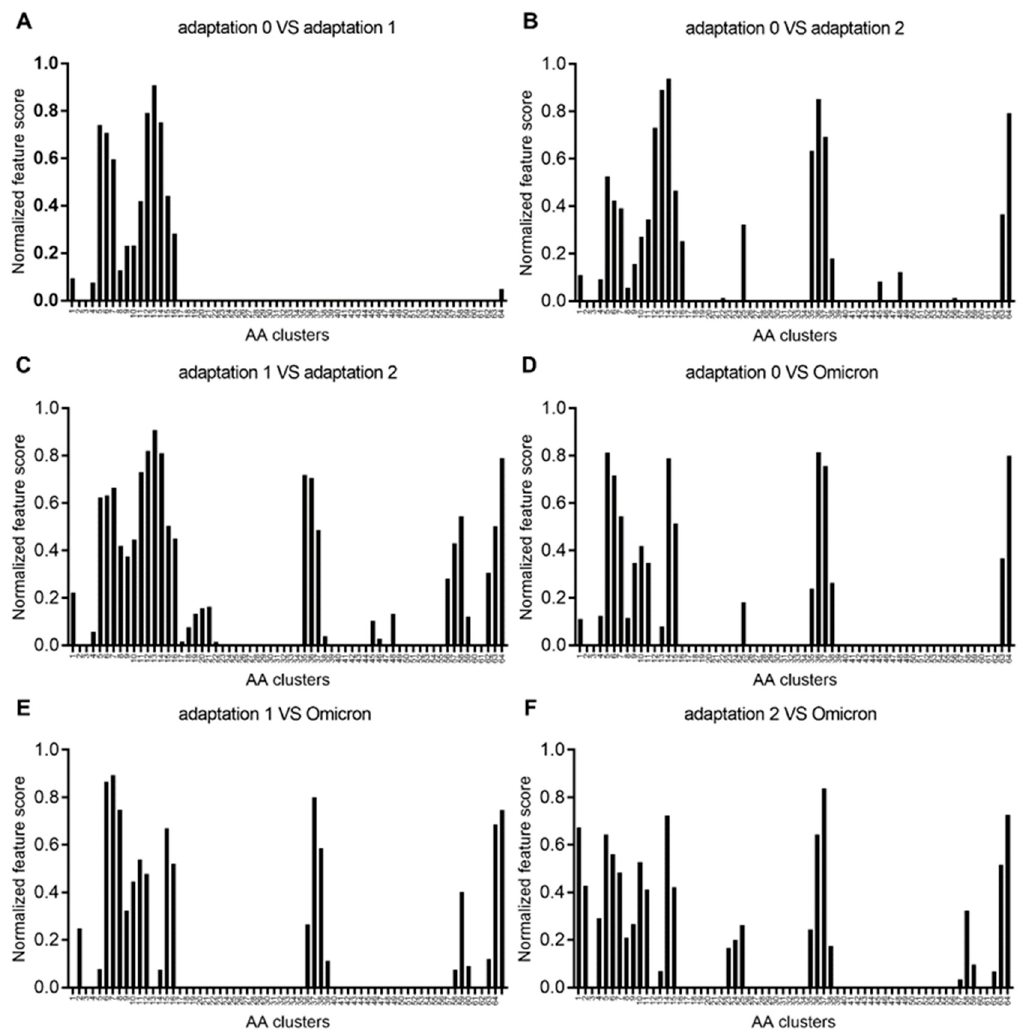
Figure 3. Importance of serially segmented AA clusters for three types of human adaptation of SARS-CoV-2 variants. Normalized dot product value of AA sites in Spike genes between adaptation 0 and adaptation 1 ( A ), adaptation 0 and adaptation 2 ( B ), adaptation 1 and adaptation 2 ( C ), adaptation 0 and Omicron ( D ), adaptation 1 and Omicron ( E ), and adaptation 2 and Omicron ( F